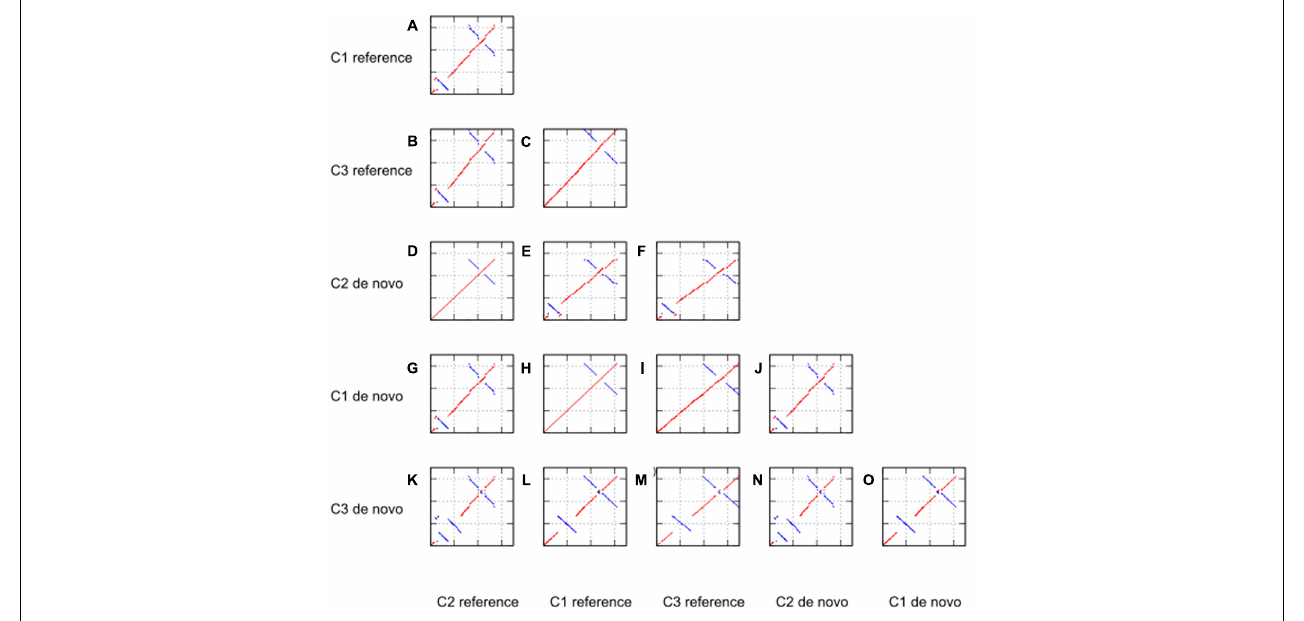
FIGURE 3 | Dotplot analyses against reference genome and de novo assembled genome for case study 1 (C1, tomato), 2 (C2, Ae. tauschii ), and 3 (C3, P. henryanum